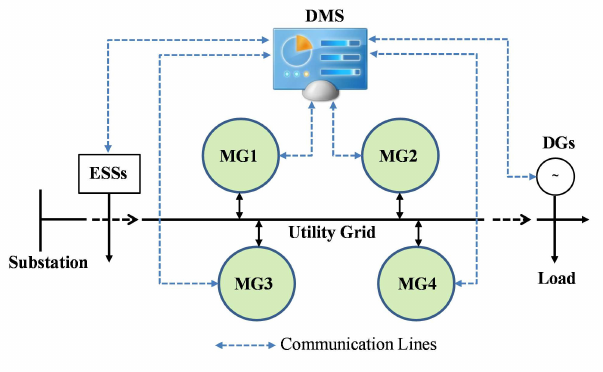
Figure 1. Modern distribution grids with networked microgrids, DGs and